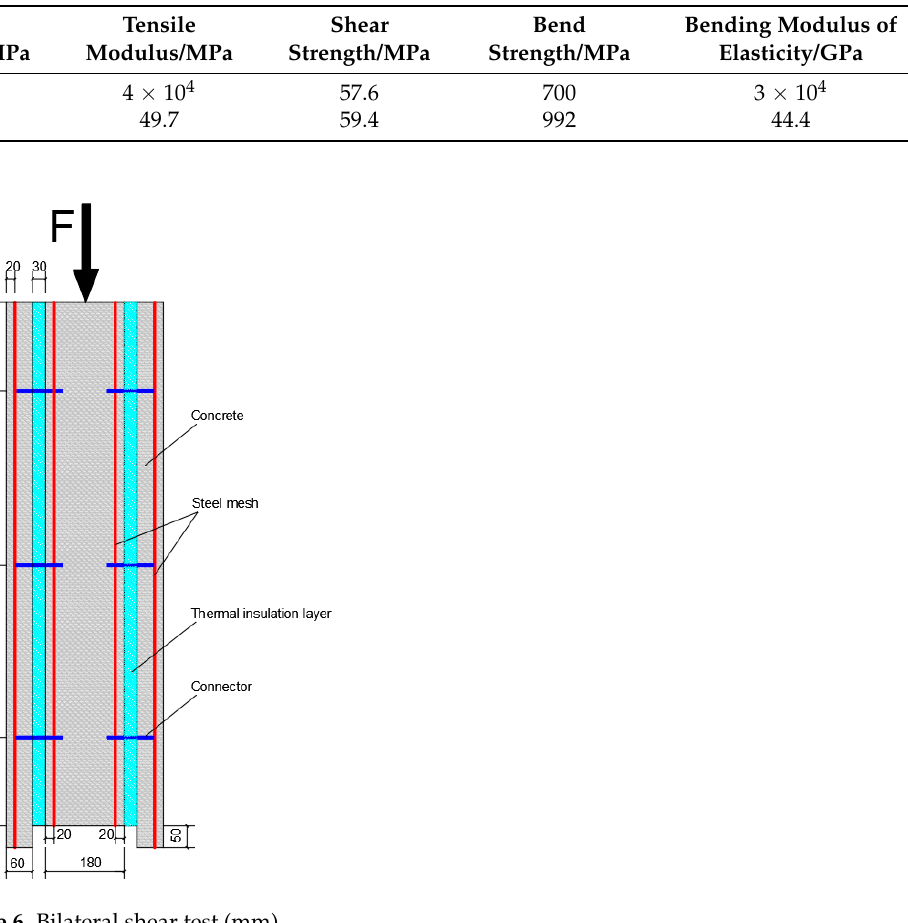
Figure 5. L2 connector. ( a ) Real image; ( b ) size detail (mm). Table 4. Material properties of connectors.